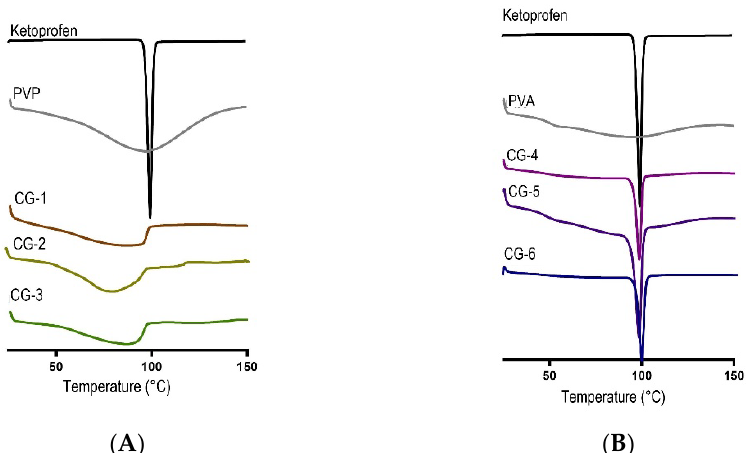
Figure 6. ( A ) Thermogram DSC Co-grinded Ketoprofen with PVP; ( B ) Thermogram DSC Co-grinded Ketoprofen with PVA.